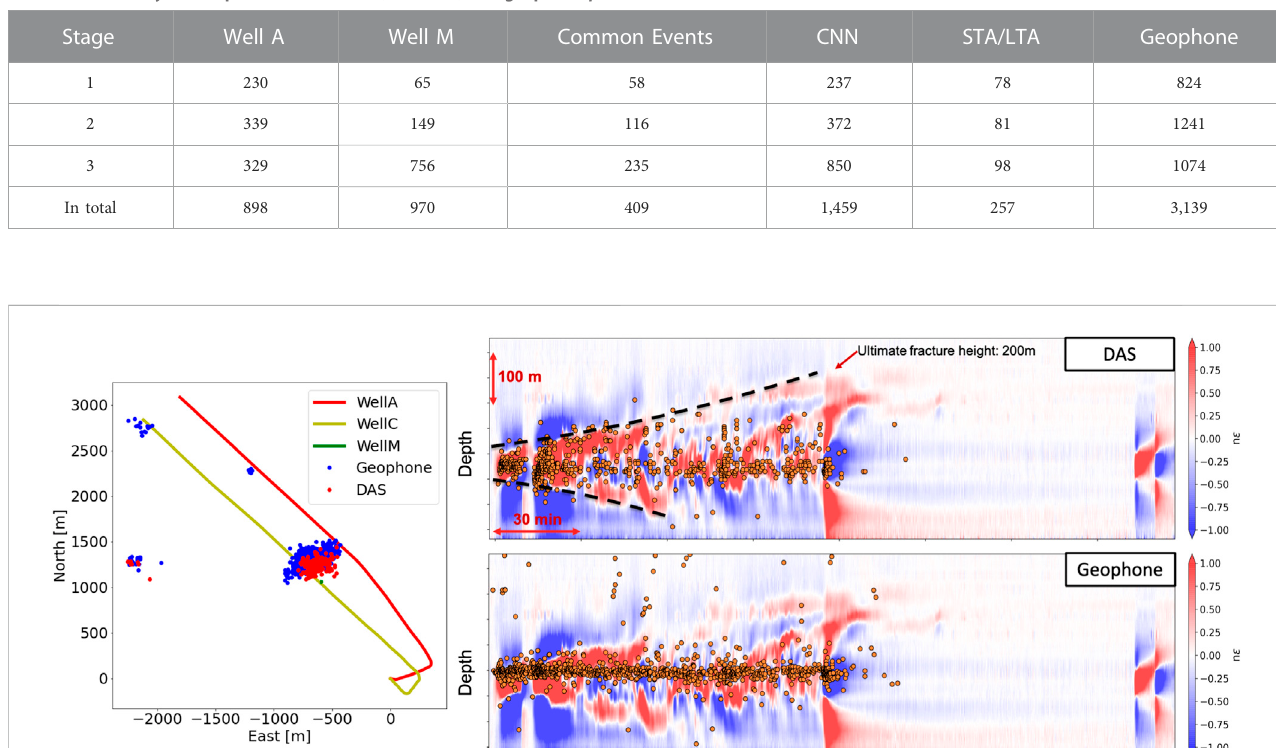
TABLE 2 Case study 2: Comparison of DAS CNN, STA/LTA, and geophone performance for event detection . Stage Well A Well M